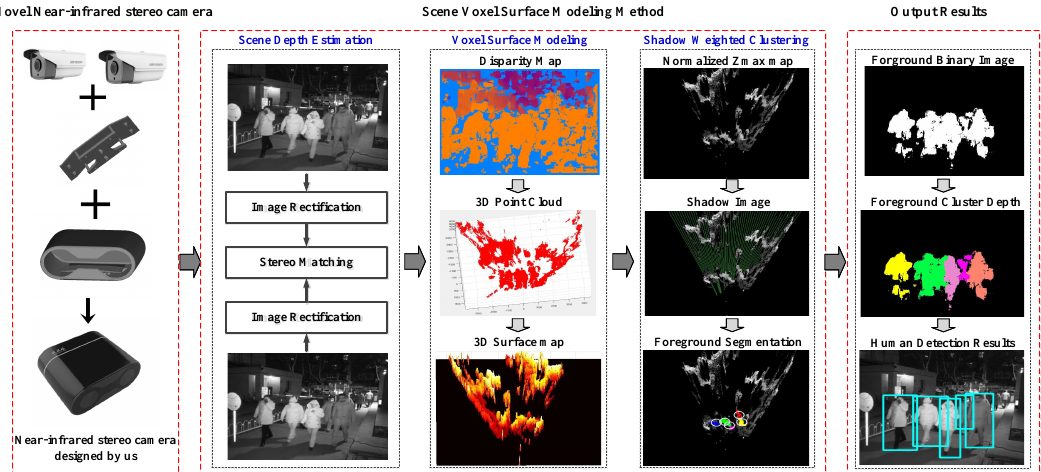
Figure 2. The framework of the proposed nighttime pedestrian detection algorithm and system. ( Left ): We build a network binocular camera with two calibrated commercial near-infrared cameras; ( Middle ): The voxel surface model for foreground pedestrian detection in dynamic scenes; ( Right ): Three kinds of outputs of our system, including the foreground binary image, foreground cluster depth and bounding boxes of the